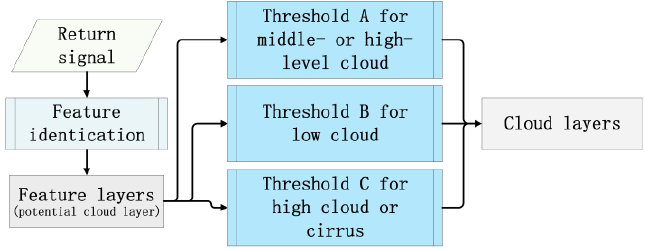
Figure 2. Flow chart of the cloud layer detection algorithm.